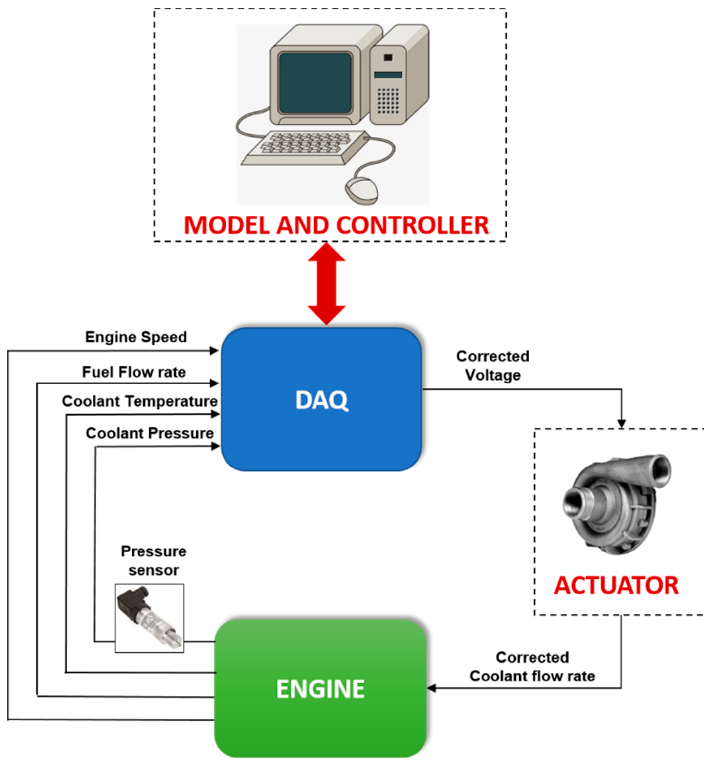
Figure 2. Operating scheme of the controller at the experimental test rig.